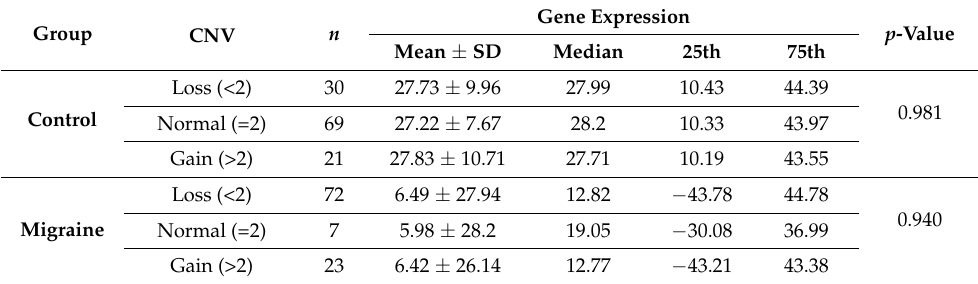
Table 5. Mean, median, and p -values of CHRNA7 gene expression and CNV in migraine patients and control